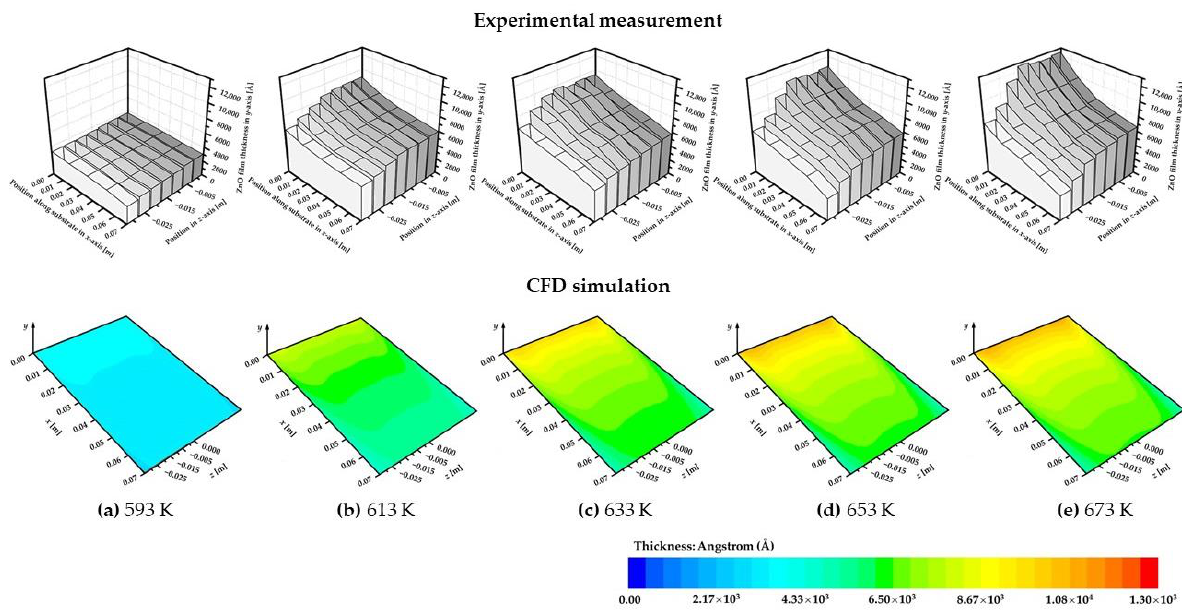
Figure 5. Contours of ZnO thickness on the substrate at the temperature of ( a ) 593 K; ( b ) 613 K; ( c ) 633 K; ( d ) 653 K and ( e ) 673 K (Note: due to symmetry, only half of the substrate width, the along z -axis with the interval of 0 to −0 .0032 m, is shown for the experimental data).